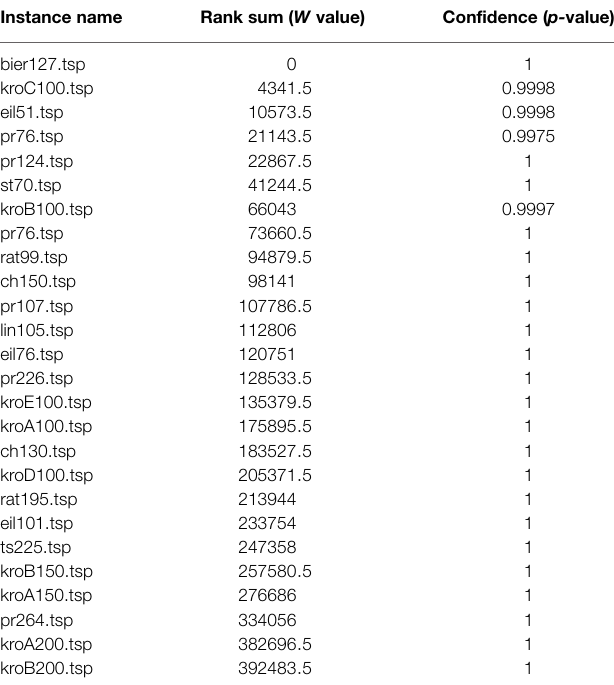
TABLE 4 | Results of the Wilcoxon signed rank tests on the predicted and actual approximation ratios for all parameter combinations of the TSPLib instances, for the hypothesis “predicted>actual”, positive rank sum ( W ) and confidence ( p ) values are displayed accordingly